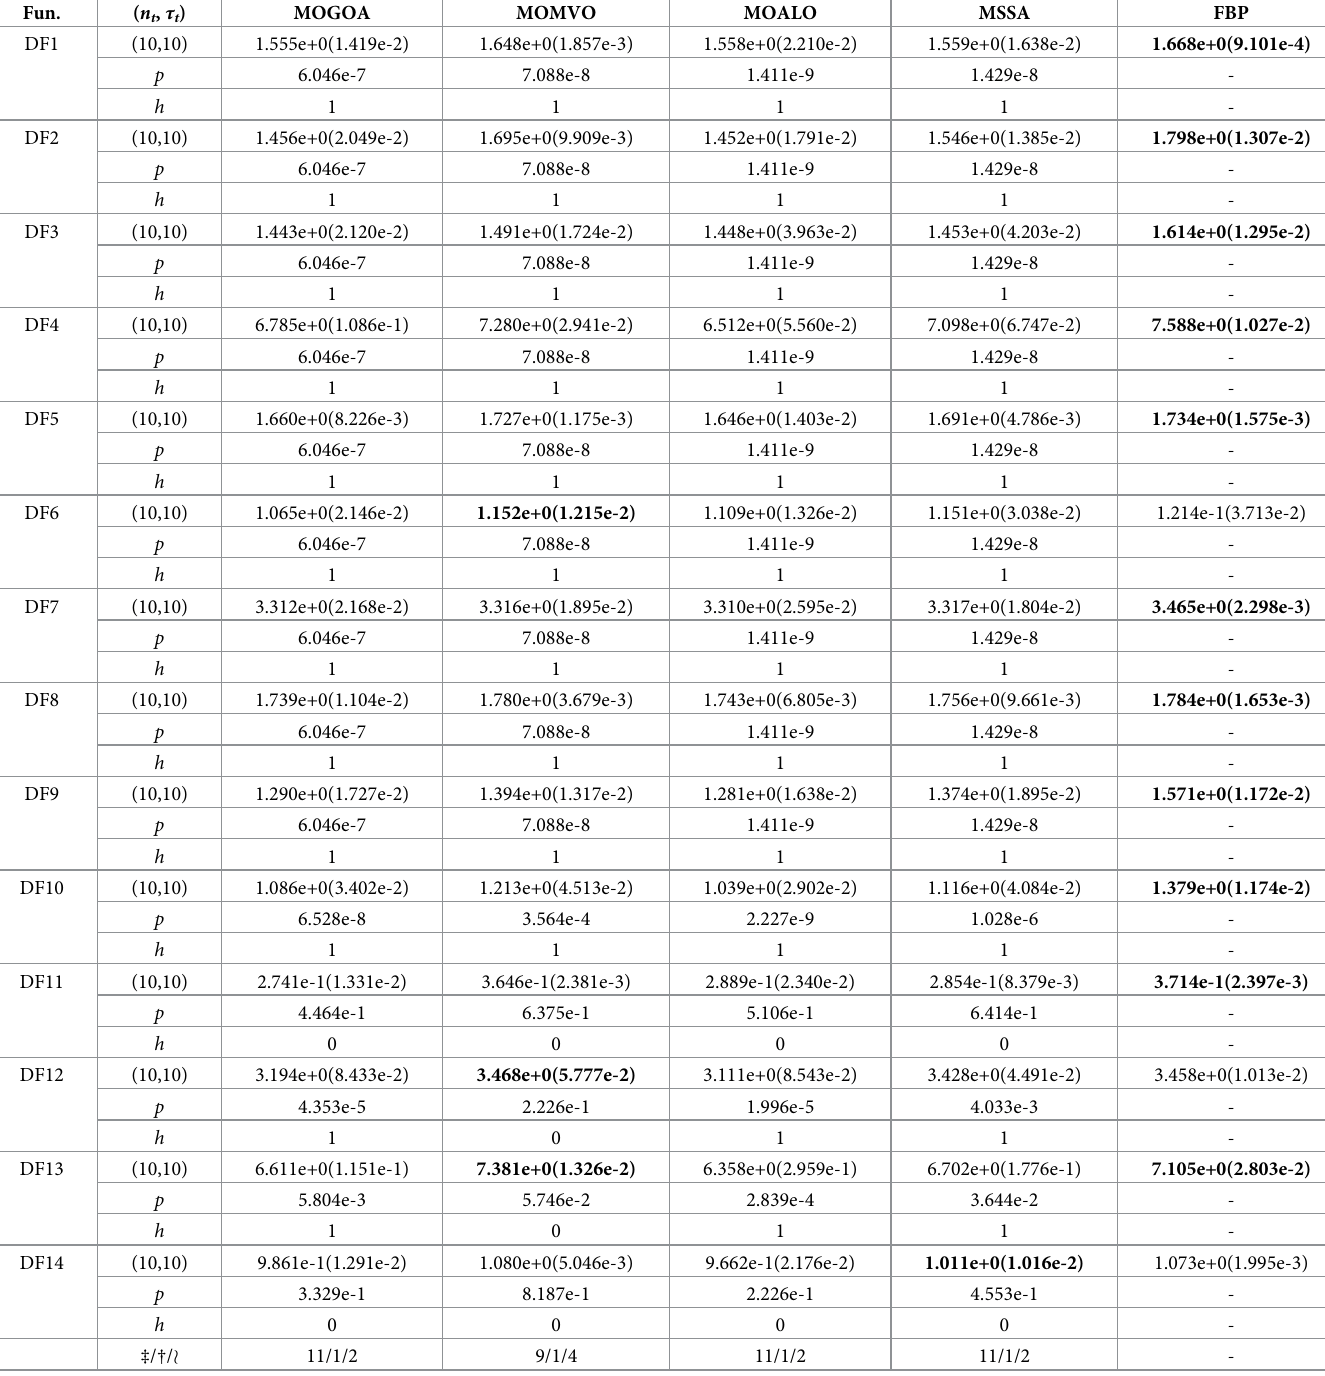
Table 11. Performance comparison of different multiobjective algorithms variants on MHV.